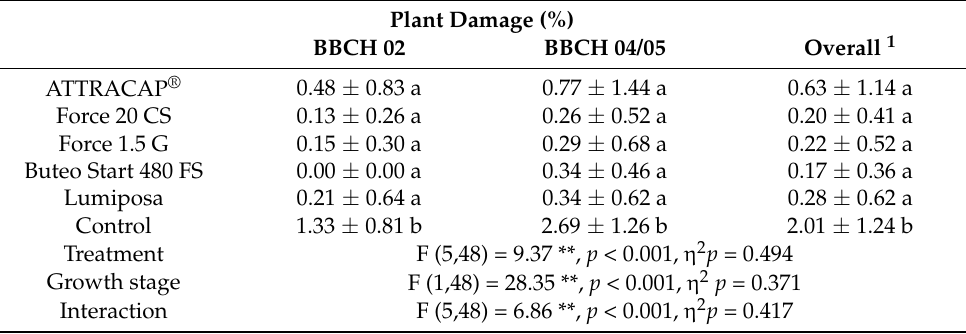
Table 4. Plant damage depending on insecticidal treatments at RŠ Field 1 in